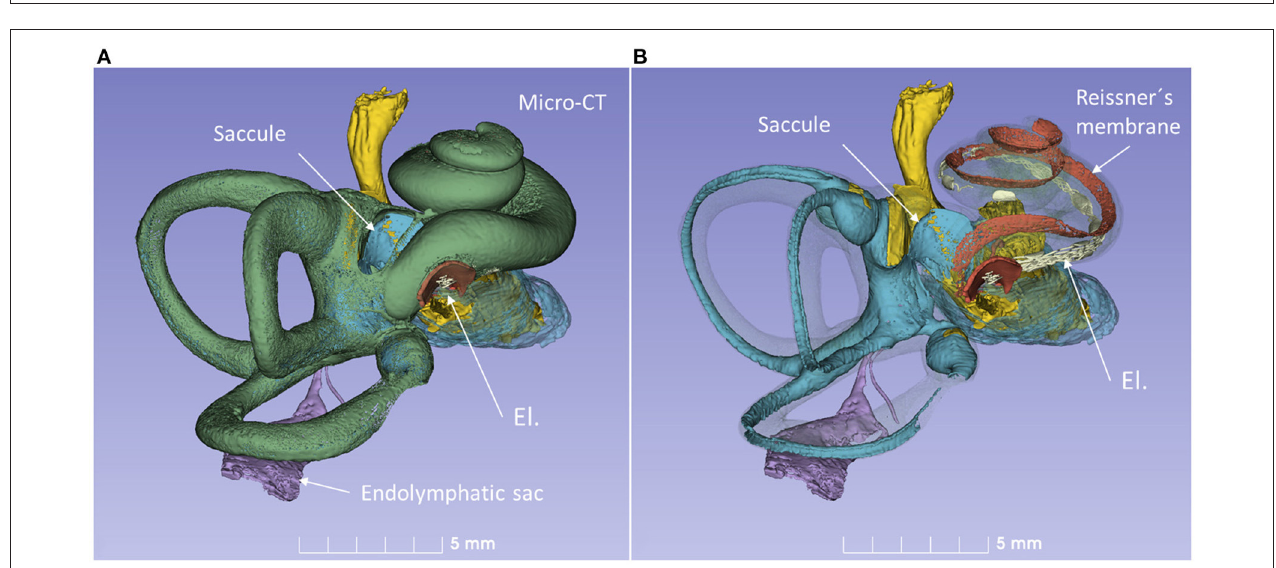
FIGURE 7 | Micro-CT 3D reconstruction of a left human temporal bone (lateral view). An ACO (3) was made, and the distances to the saccular (4) and utricular (5) nerve foramina can be assessed (inset). Virtual AICO (2) and ICO (1) are shown with fiducials.